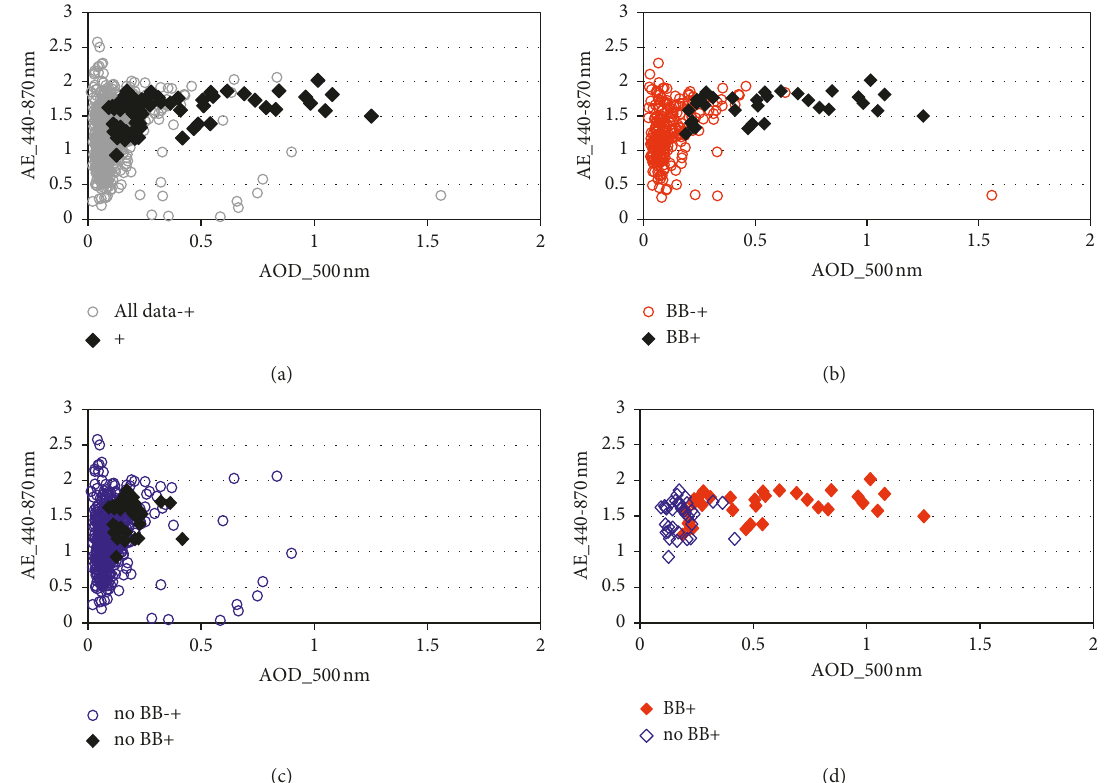
Figure 4: Variation of ˚Angstr¨om exponent with AOD500nm at CEILAP-BA in the five-year period 2001–2005. (a) Black diamond: days with regional transport of biomass-burning aerosols (selected dates). Open circle: daily data with the selected days excluded: (b) same as (a) during biomass-burning months (August to September); (c) same as (a) during no-burning months; and (d) days with regional transport of biomass-burning aerosols, red diamond: biomass-burning months, and blue diamond: no-burning months. + denotes the “selected dates.”